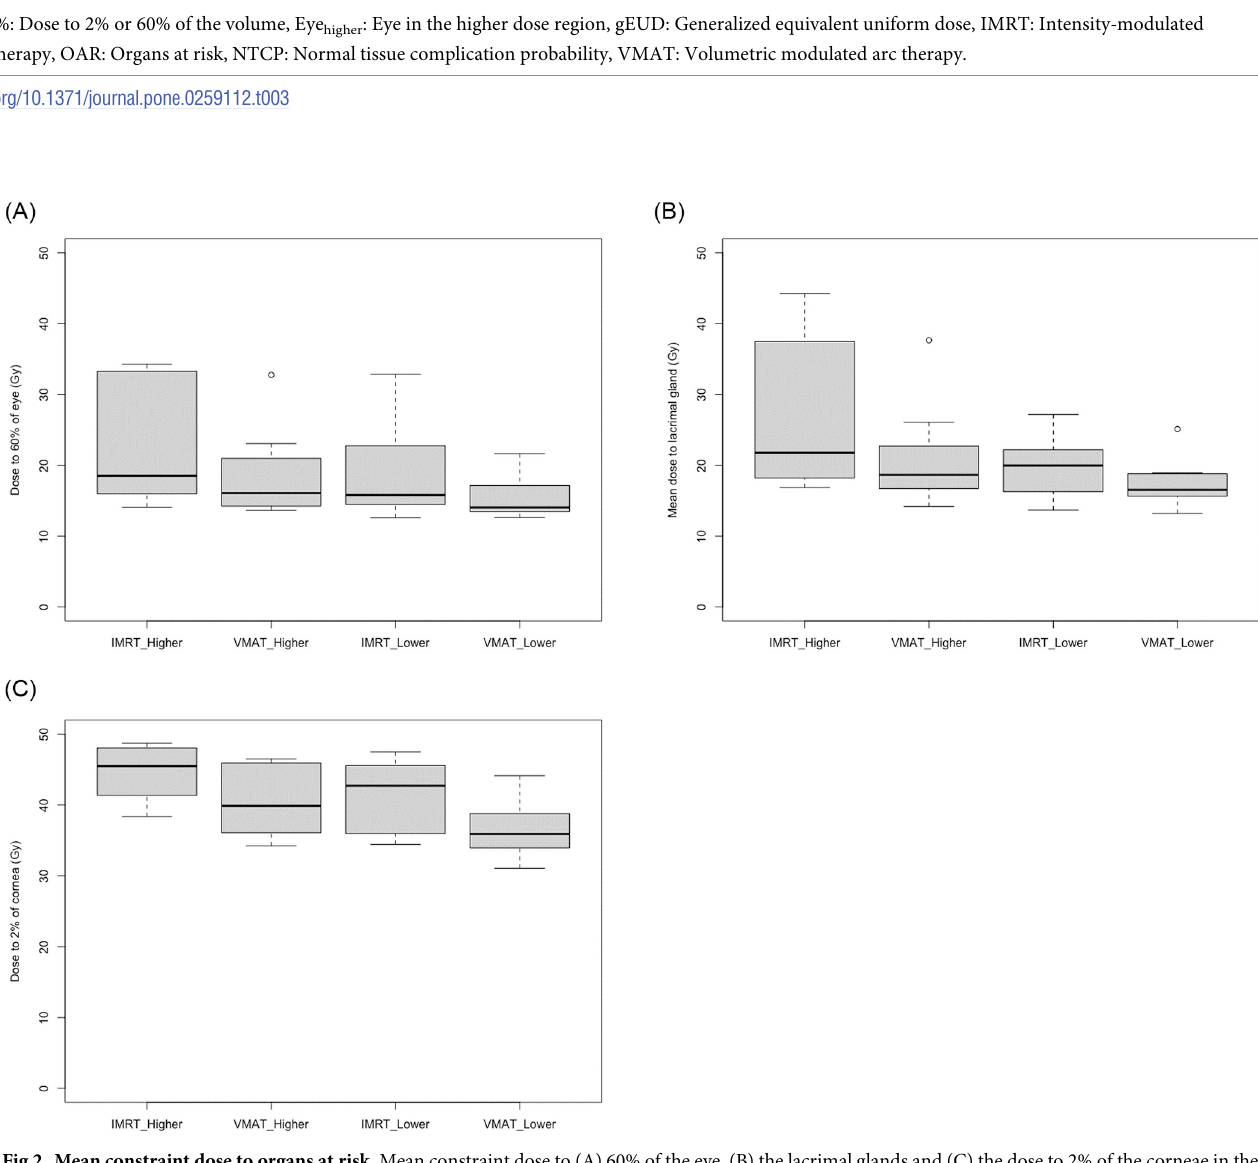
Fig 2. Mean constraint dose to organs at risk. Mean constraint dose to (A) 60% of the eye, (B) the lacrimal glands and (C) the dose to 2% of the corneae in the respective organ at risk in the high and lower dose region for each IMRT and VMAT treatment plans, respectively (for individual P-values see Table 3). IMRT: Intensity modulated radiation therapy; VMAT: Volumetric modulated arc